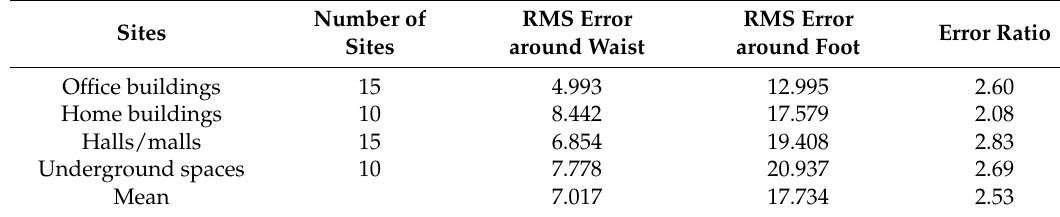
Table 1. Indoor magnetic heading